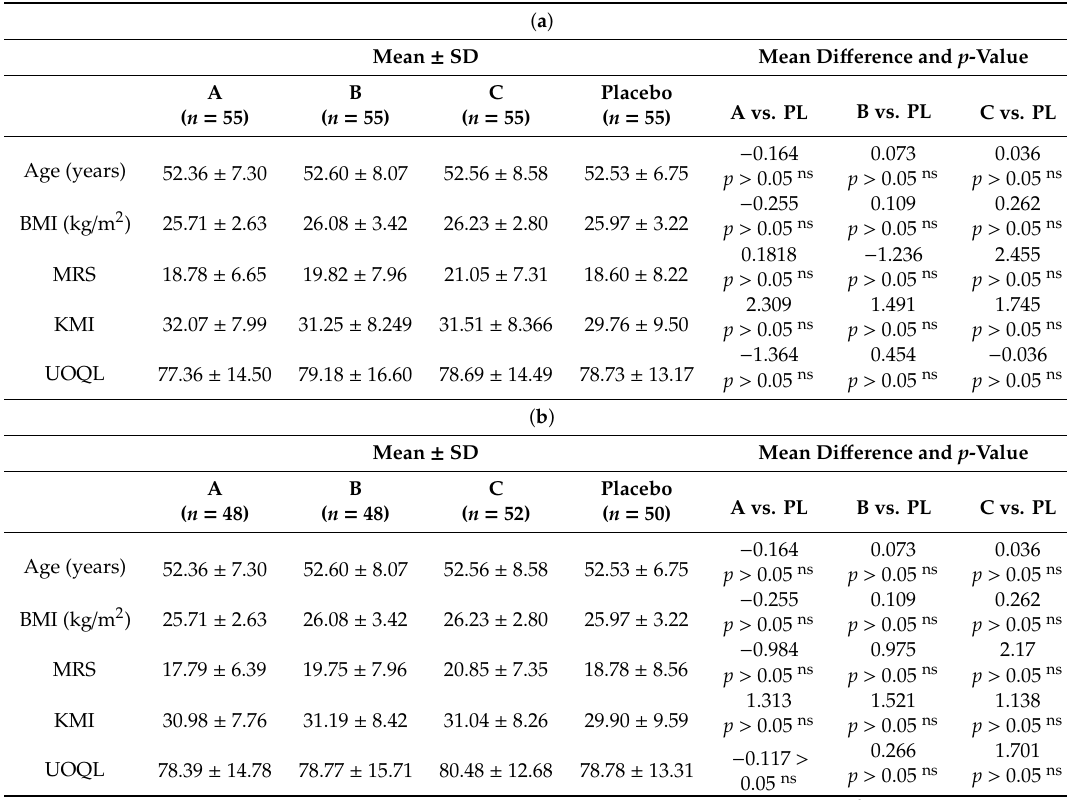
Table 1. ( a ) Baseline demographic and e ffi cacy outcome measures; ( b ) baseline characteristics of patients who completed the treatment per protocol